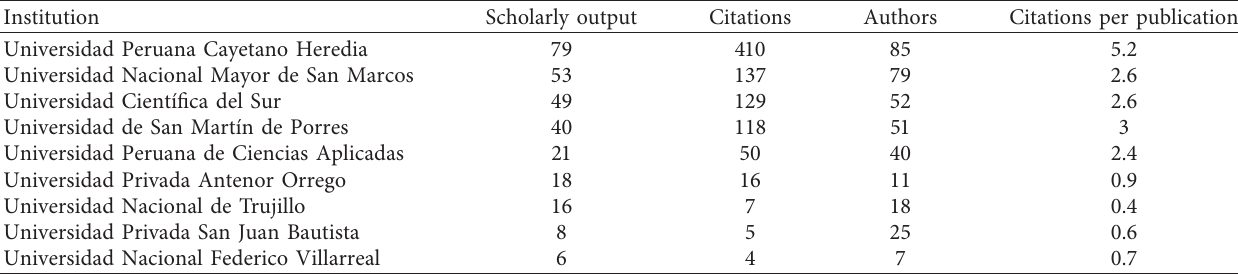
Table 4: Top 10 in scholarly output in Scopus of all the Peruvian public and private dental schools